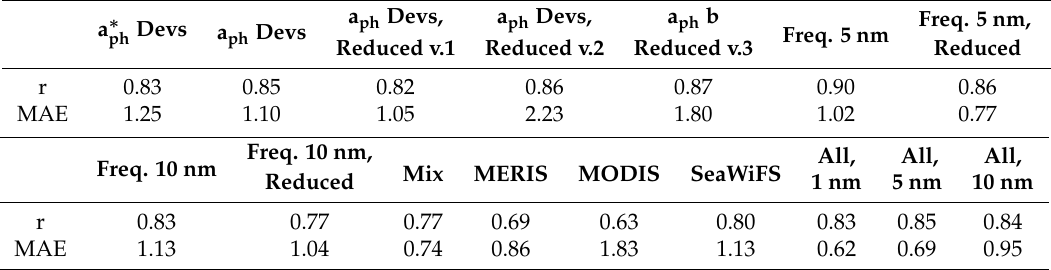
Table 2. Correlation coefficients (r) and mean absolute errors (MAE) calculated between the retrieved diatoms chl-a concentrations and their input concentrations. Retrievals are performed on band